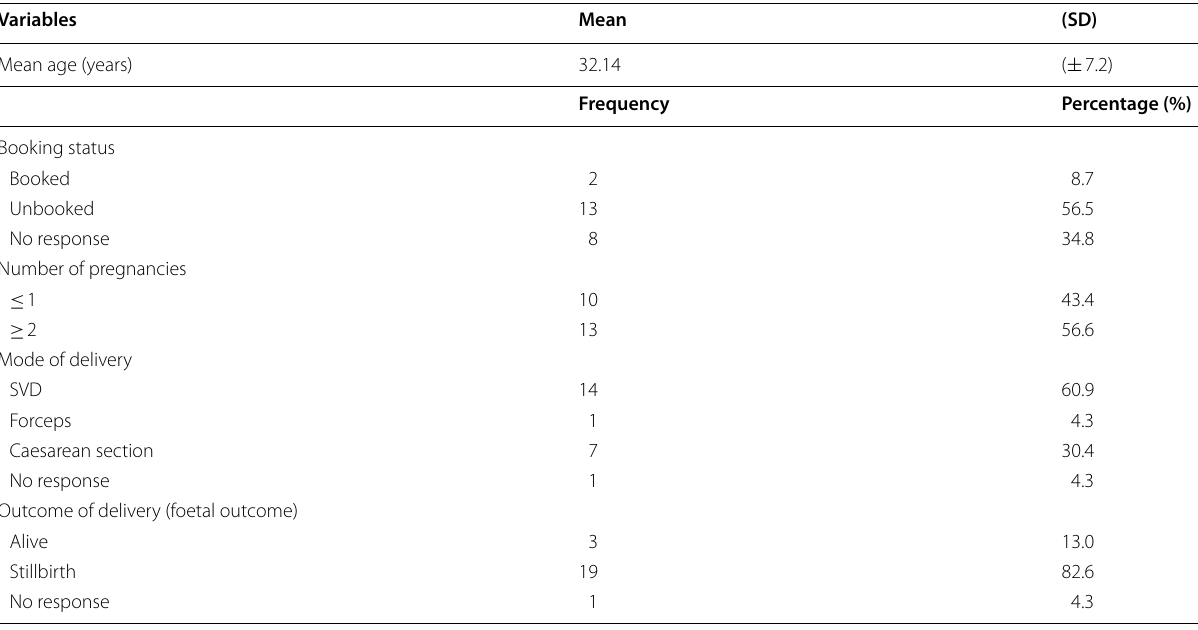
Table 1 Demographic and obstetric characteristics of participants